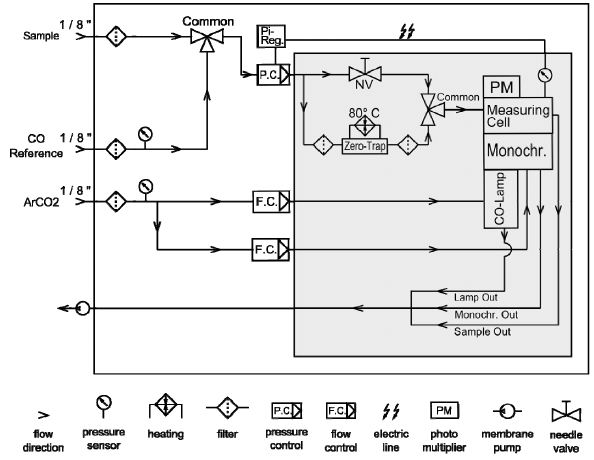
Fig. 1. Flow scheme of the CARIBIC CO instrument. The individ- ual components are described below the